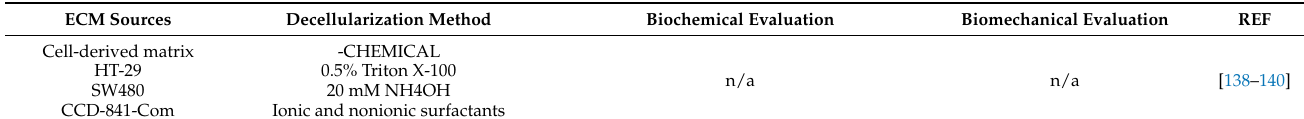
Table 1. Methods used for the decellularization and evaluation of biochemical/biomechanical properties of decellularized ECM from colorectal